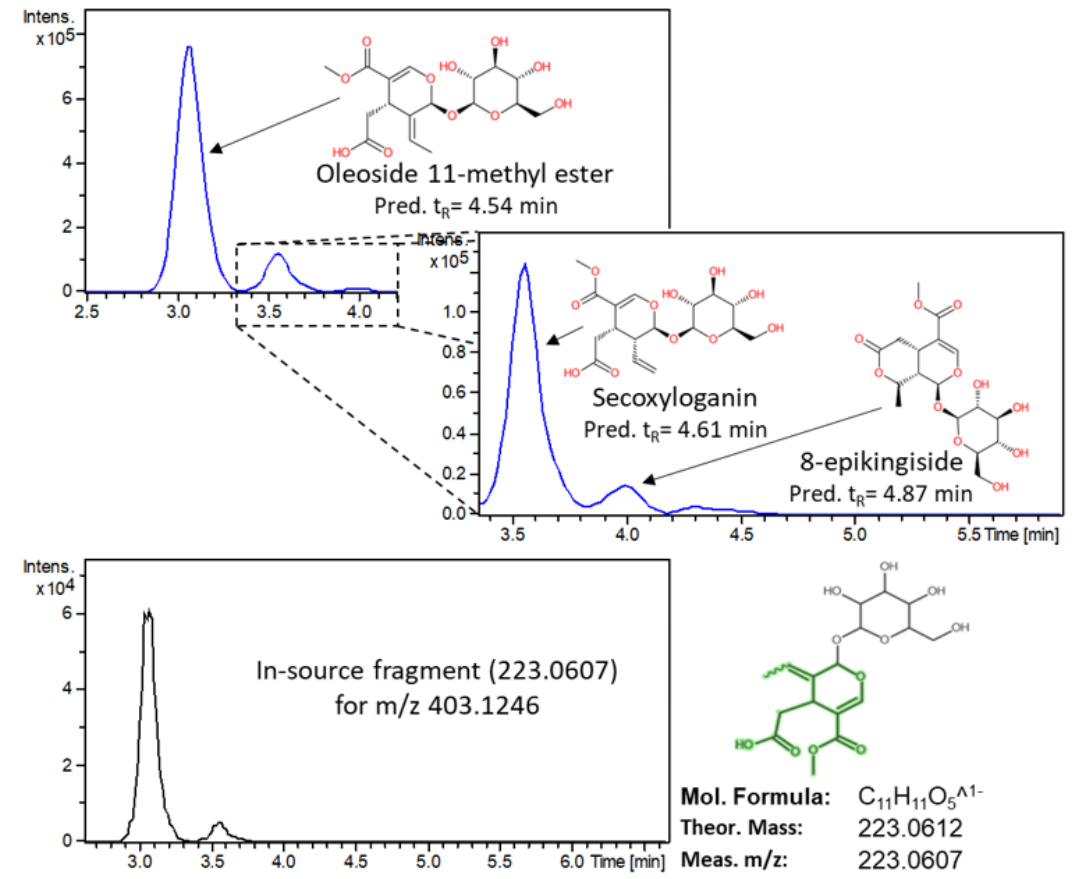
Figure 5. Structural elucidation and prioritization of candidates for the m / z value 403.1246.